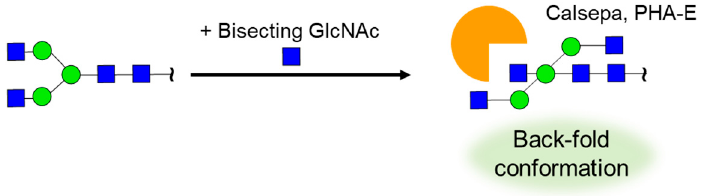
Figure 6. Recognition of bisecting GlcNAc containing N -glycan by Calsepa and Phaseolus vulgaris erythroagglutinin (PHA-E). Attachment of bisecting GlcNAc enhances back-fold conformation, which is recognized by Calsepa and PHA-E.